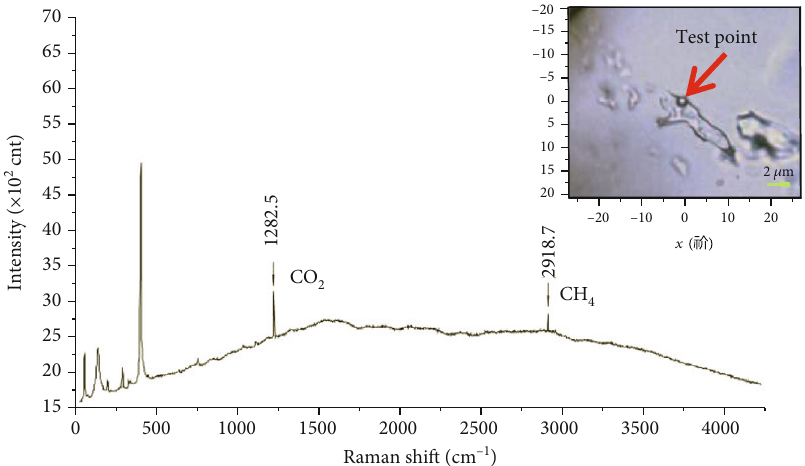
Figure 12: Laser Raman spectroscopy of fl uid inclusions in quartz cements for the Es